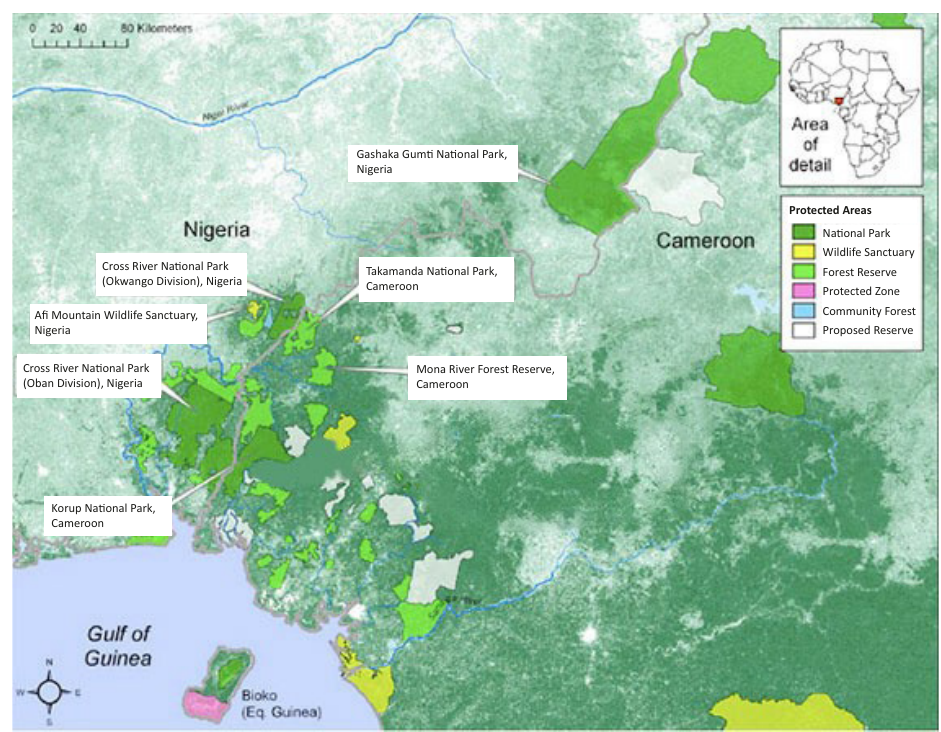
Figure 4. Locations of neighbouring protected areas in Nigeria and